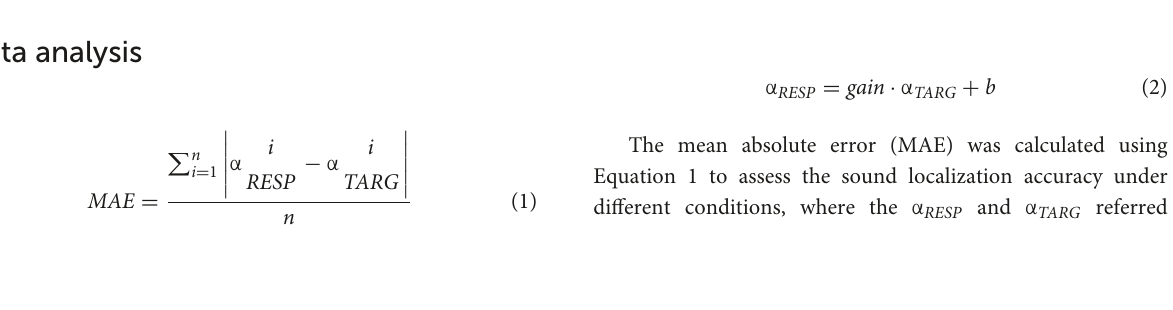
The mean absolute error (MAE) was calculated using Equation 1 to assess the sound localization accuracy under different conditions, where the α RESP and α TARG